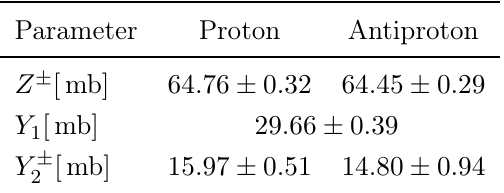
Table 1 . Parameters obtained in the description of the (anti)proton-deuterium cross-sections along with their